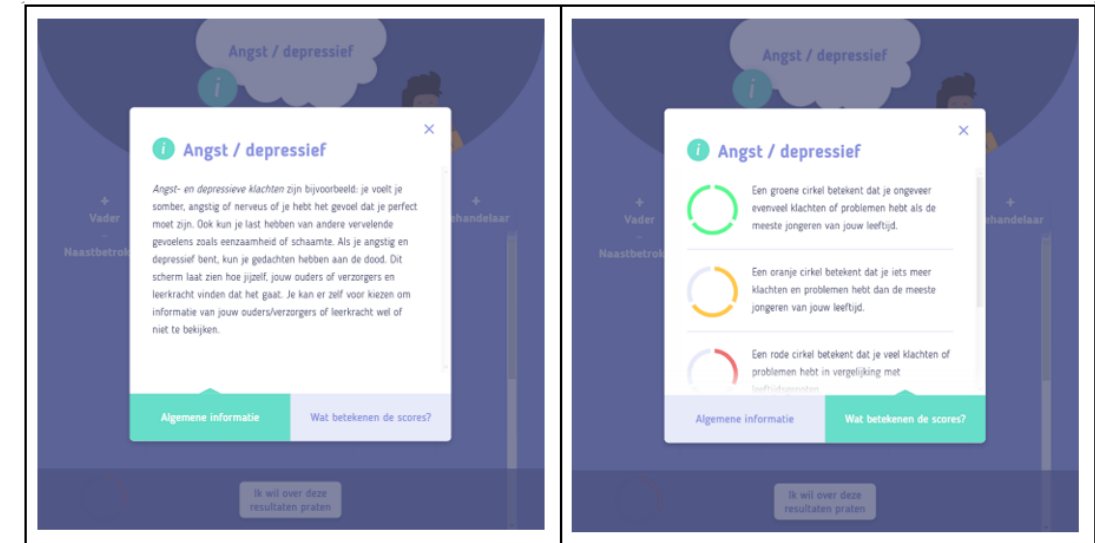
Figure 10. Final version of the INK tool.